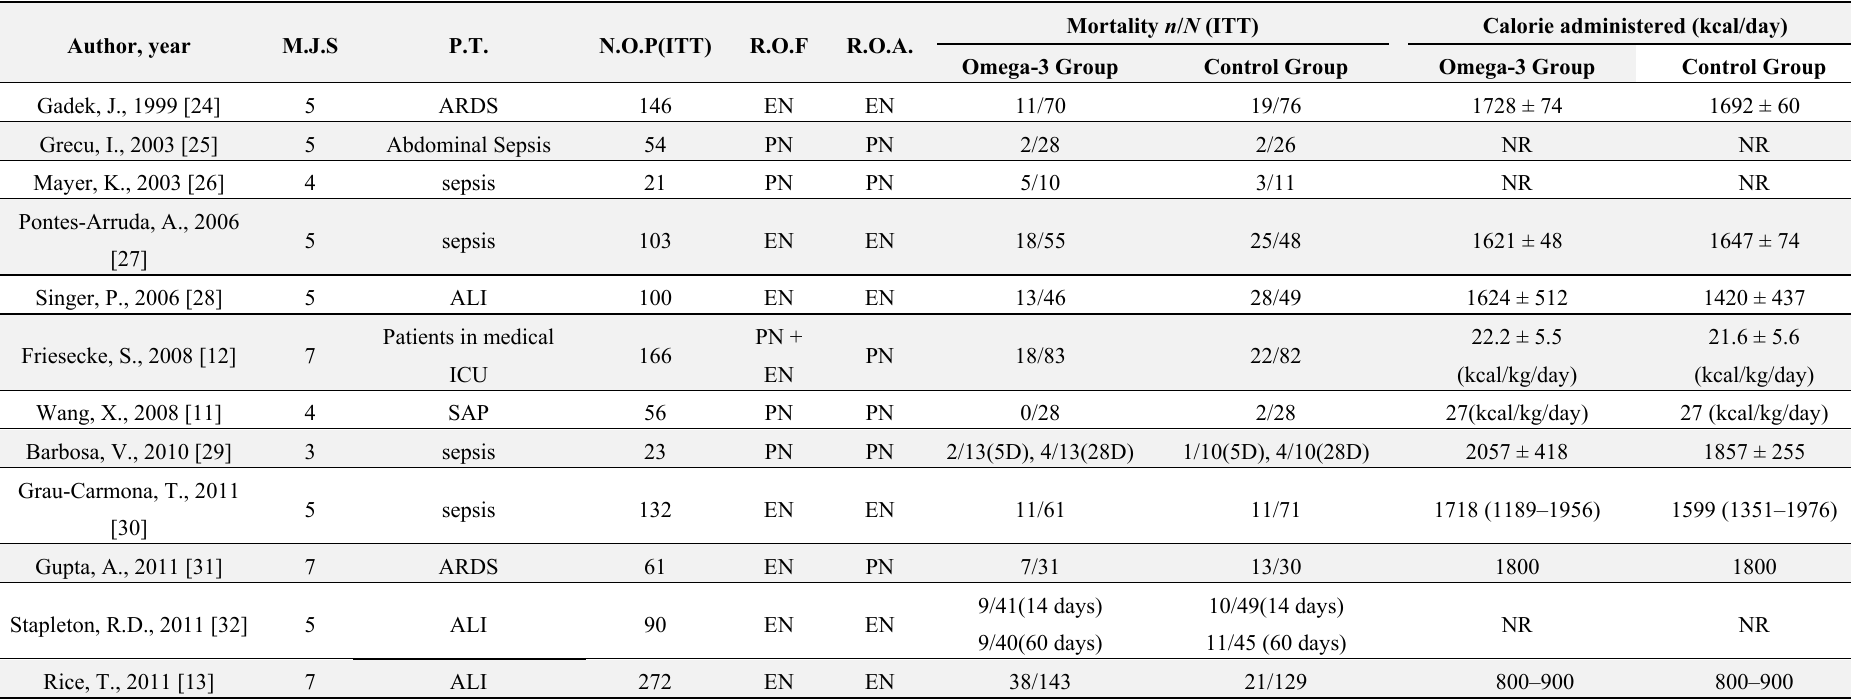
Table 3. RCTs of Omega-3 fatty acids supplementation for severe